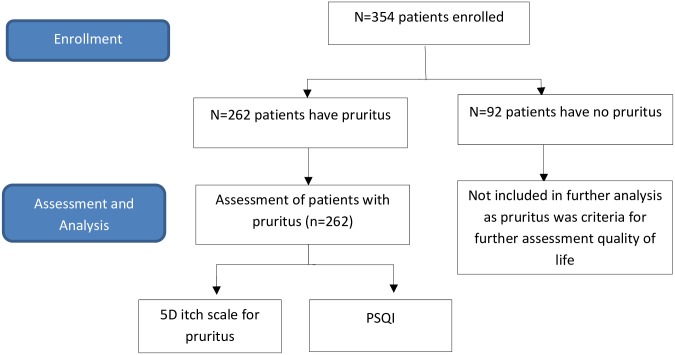
Study flow diagram.